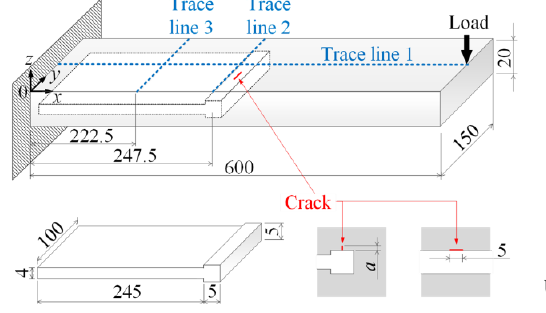
Figure 2. Shape and dimensions of the three-dimensional model.